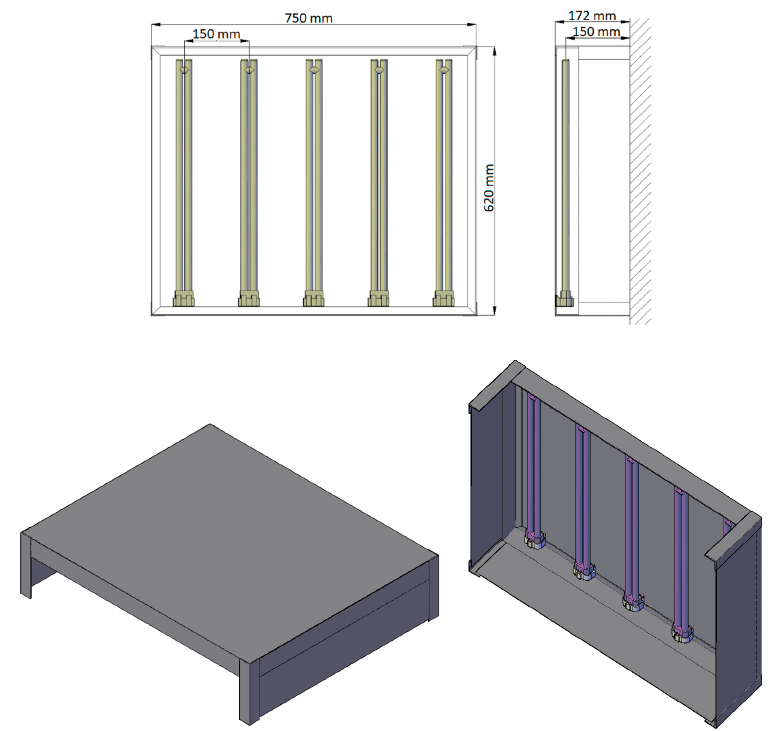
Figure 3. Dimensions and 3D visualization of the completed sterilizer.